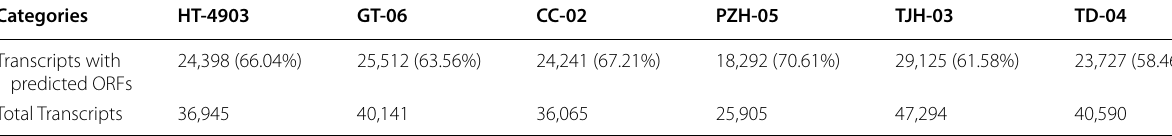
Table 3 The number of predicted ORFs in six H. erinaceus